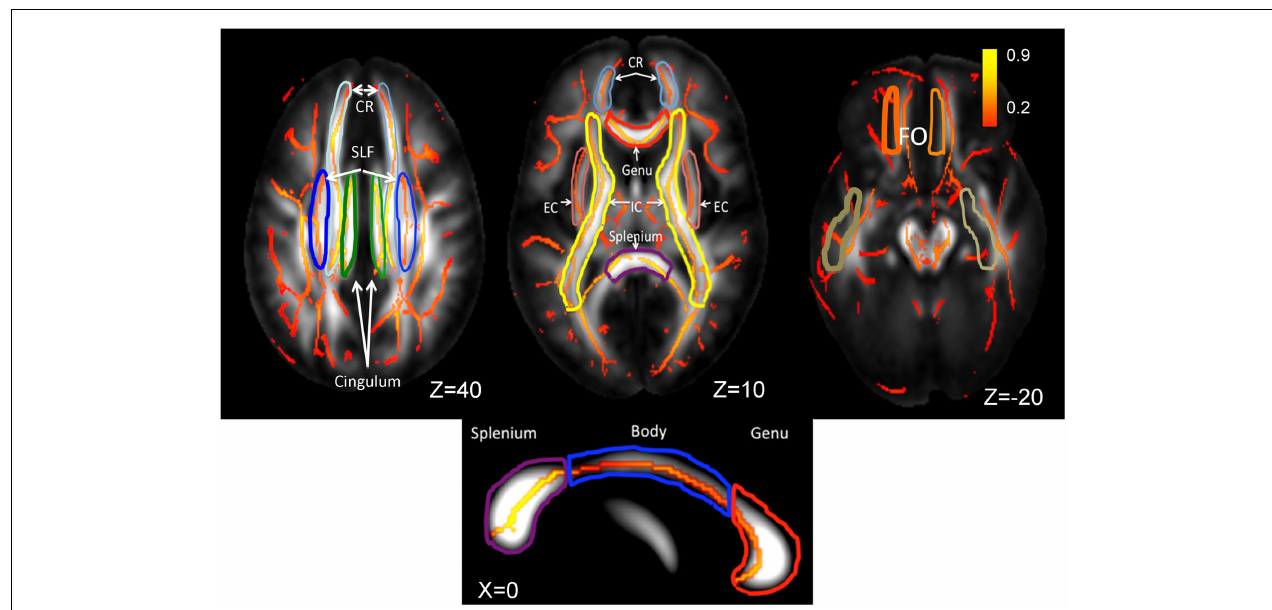
and the genu, body, and splenium of corpus callosum.The population-wise average FA values are color coded on the skeleton of the tract.The location of the axial slices (the Z -coordinate) is provided in theTalairach reference frame. The three segment of Corpus Callosum are shown on the mid-sagittal slice (Talairach X = 0).